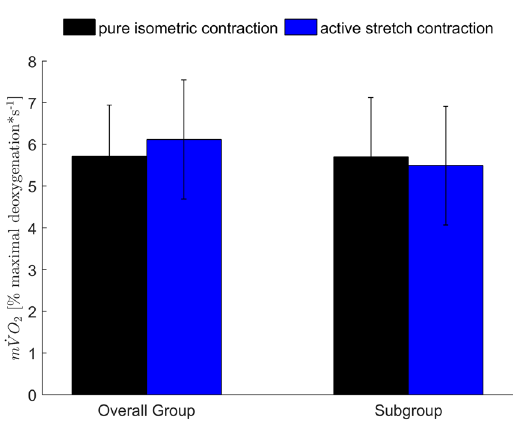
Figure 4. Results (mean ± standard deviation) for the estimated oxygen consumption for the overall subject group (n = 20) and the subgroup (n = 10). No significant differences were found between isometric and active stretch